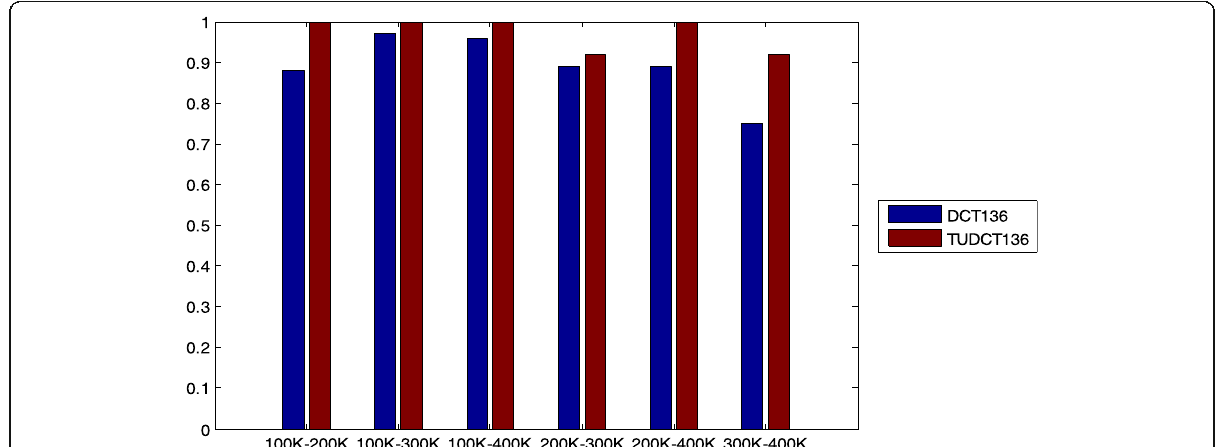
Fig. 11 The median value (MED) of detection accuracy of DCT136 [10] and